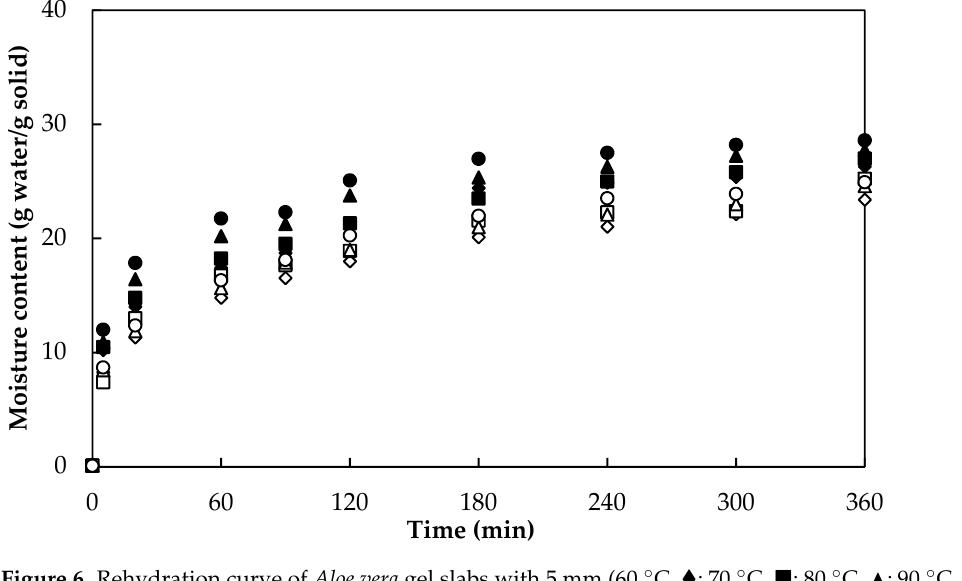
Time (min) Figure 6. Rehydration curve of Aloe vera gel slabs with 5 mm (60 ◦ C, (cid:7) ; 70 ◦ C, (cid:4) ; 80 ◦ C, (cid:78) ; 90 ◦ C, • ) Figure 6. Rehydration curve of Aloe vera gel slabs with 5 mm (60 °C, ♦ ; 70 °C, ■ ; 80 °C, ▲ ; 90 °C, ● ) and 10 mm (60 ◦ C, ♦ ; 70 ◦ C, (cid:3) ; 80 ◦ C, ∆ ; 90 ◦ C, ) thickness at 25 ◦ and 10 mm (60 °C, ◊ ; 70 °C, □ ; 80 °C, ∆ ; 90 °C, ○ ) thickness at 25 °C. (cid:35)